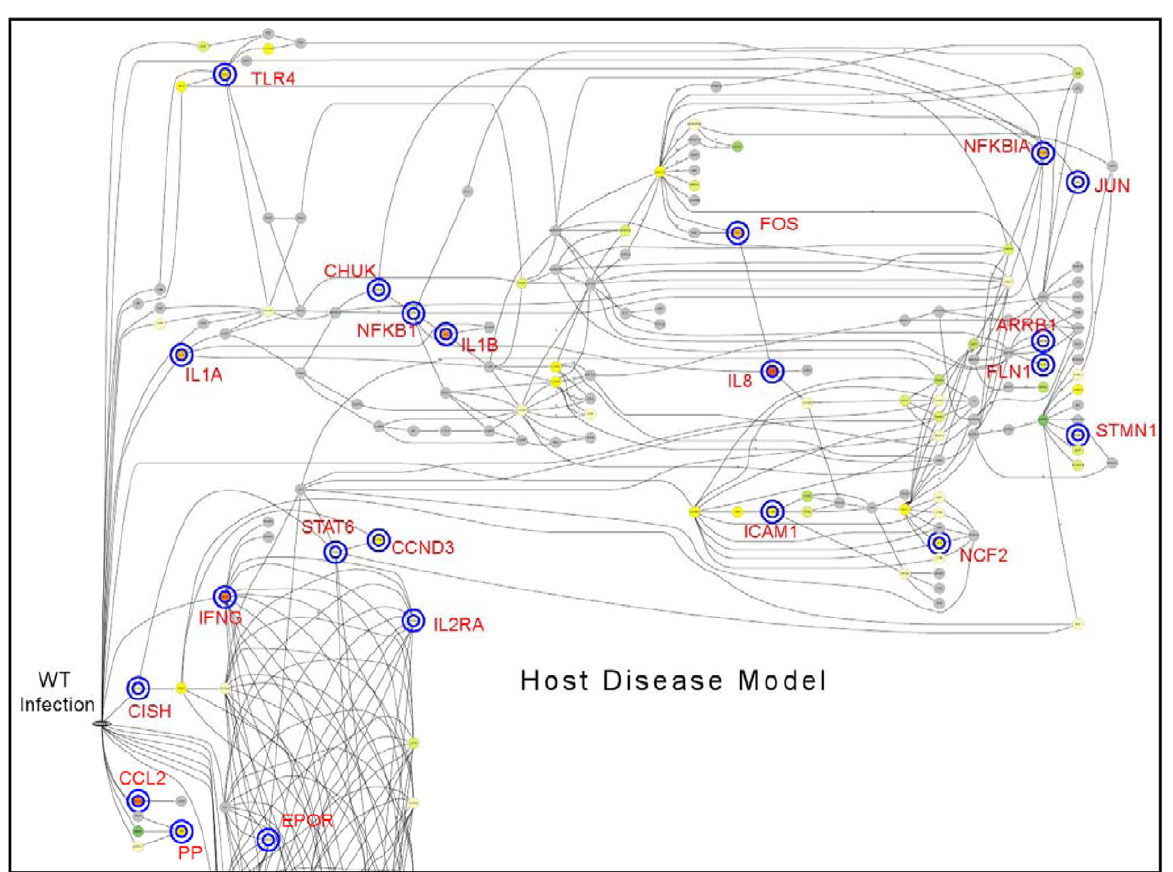
Figure 8. Dynamic Bayesian Network Disease Model of wild type S.enterica serovar Typhimurium. A host disease model was constructed by combining the network structures of the top ten scoring pathways for WT S. Typhimurium. The key mechanistic genes are labeled with their common gene names. The blue rings indicated mechanistic genes (|Bayesian z -score| . 2.24) as derived from the scoring described for the Dynamic Bayesian Gene Group Activation technique (File S1). doi:10.1371/journal.pone.0026869.g008 PLoS ONE |